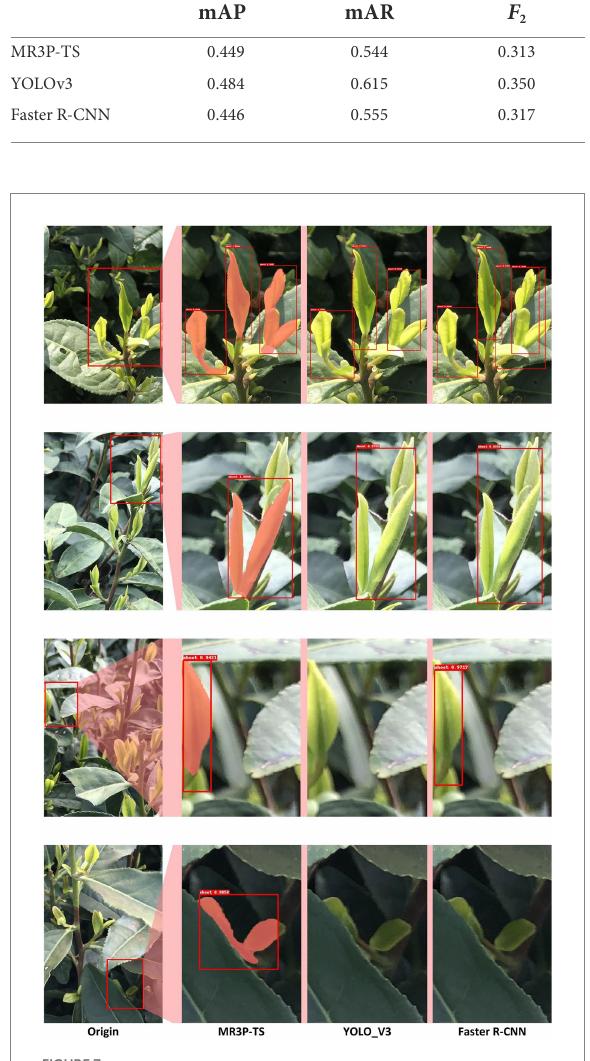
FIGURE 7 Example illustrating local details of the instance segmentation results of the MR3P-TS, YOLO_V3, and Faster R-CNN